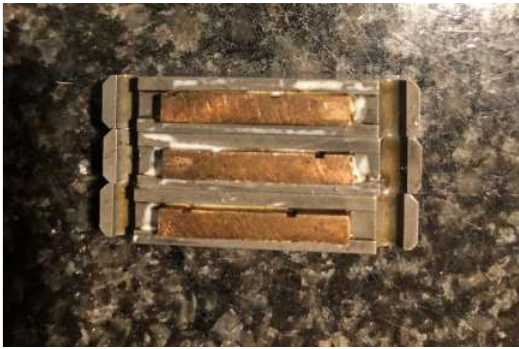
Figure 2. cBN honing stones.